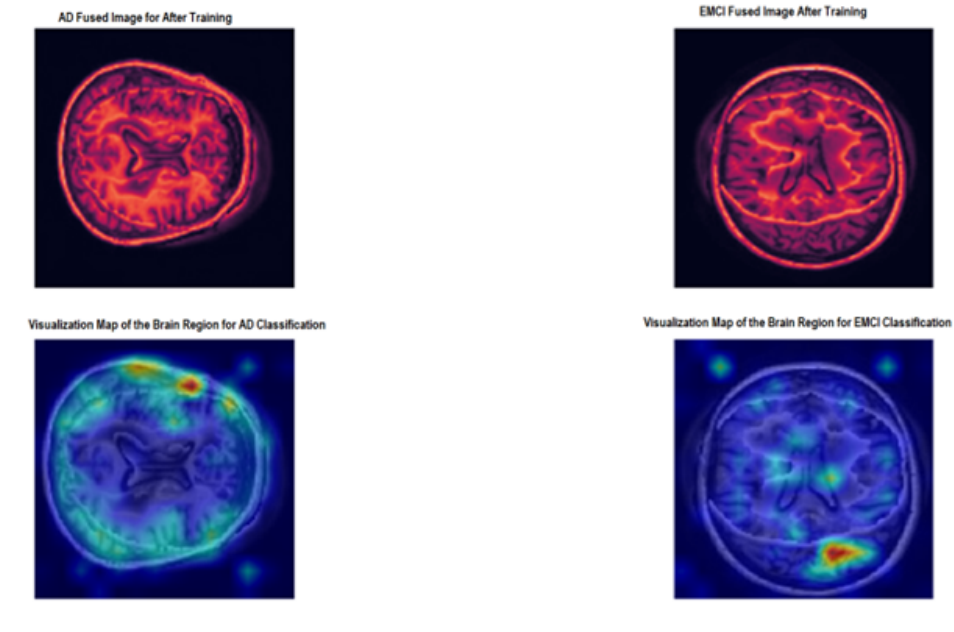
Figure 7. Relevancy Maps AD and